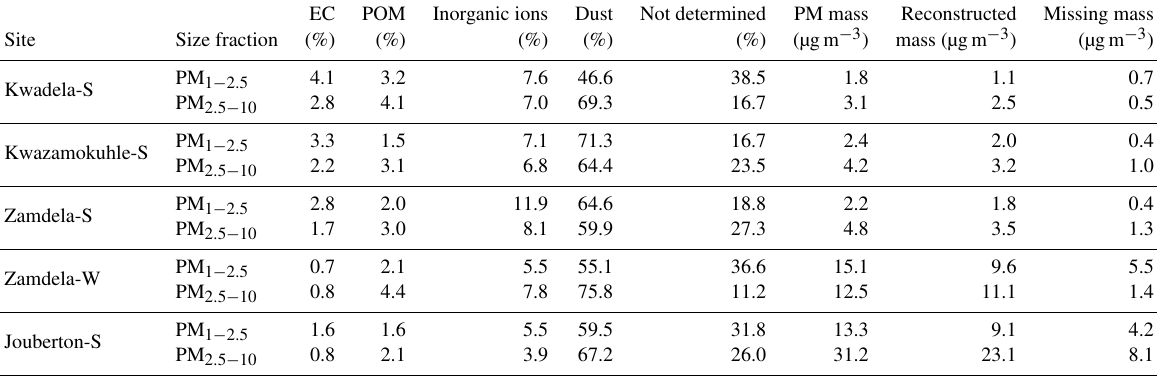
Table 7. Chemical mass closure according to the method of Guinot et al. (2007). EC POM Inorganic ions Dust Not determined PM mass Reconstructed Missing mass